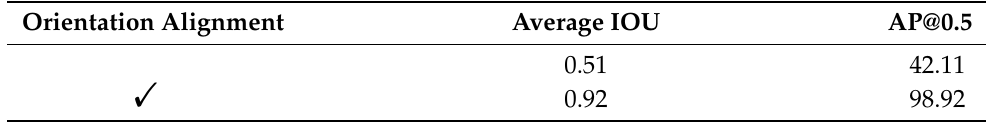
Table 2. Effectiveness of orientation alignment on the recognition of the digital box. Average IOU and AP are used as evaluation metrics for detecting